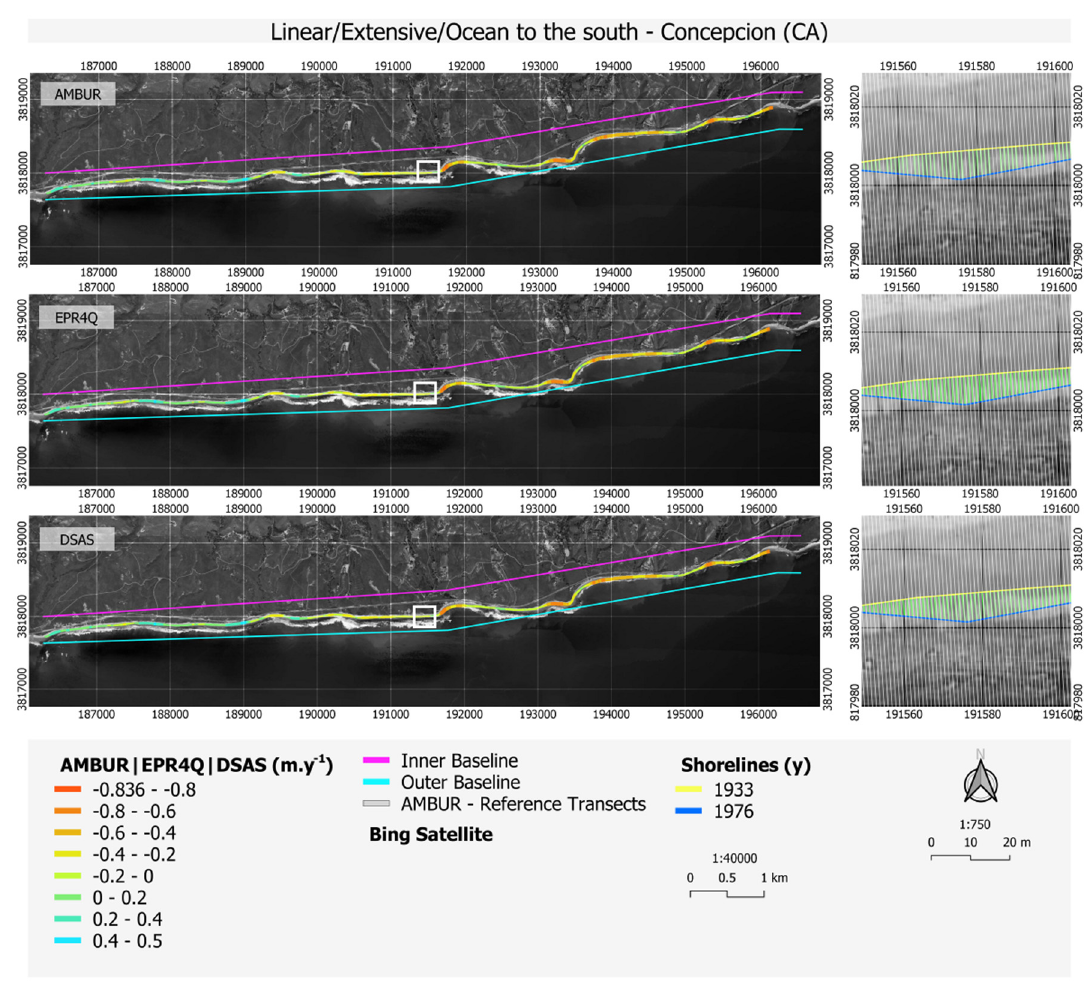
Figure 7. Shoreline changes in Concepcion using the AMBUR, EPR4Q and DSAS tools. White box shows the detail of transects with the reference transect (AMBUR unfiltered transects).